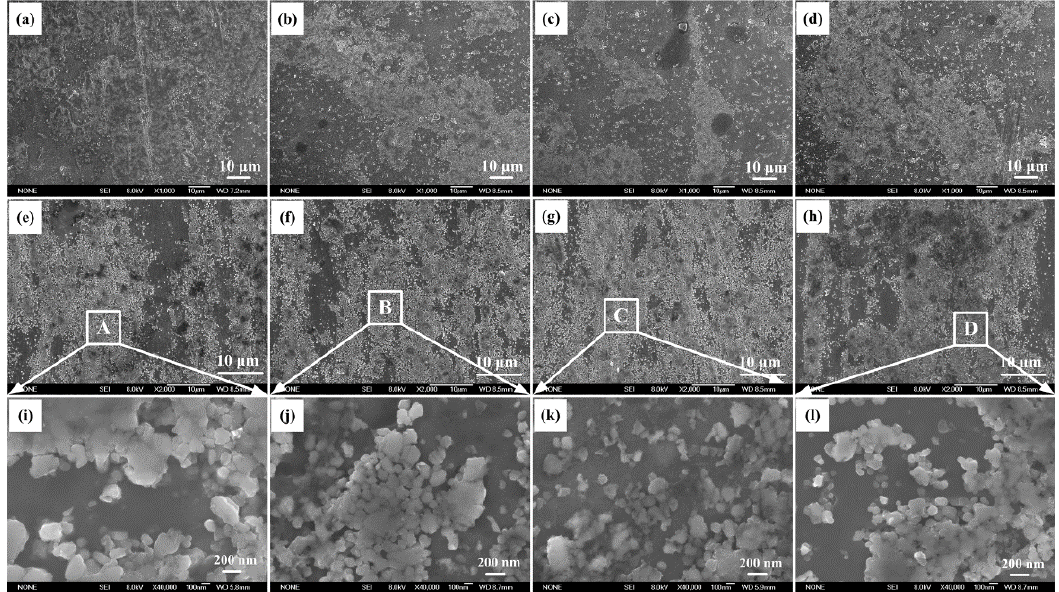
Figure 3. Field emission scanning electron microscope (FESEM) images of the synthesized nano-sized TiC x /2009Al composites fabricated by using ( a ) untreated CNTs and CNTs milled for ( b ) 1 h; ( c ) 2 h and ( d ) 3 h as the carbon source; ( e – h ) the corresponding as extruded samples and ( i – l ) the magnification of FESEM images of areas A, B, C and D in the corresponding composites.